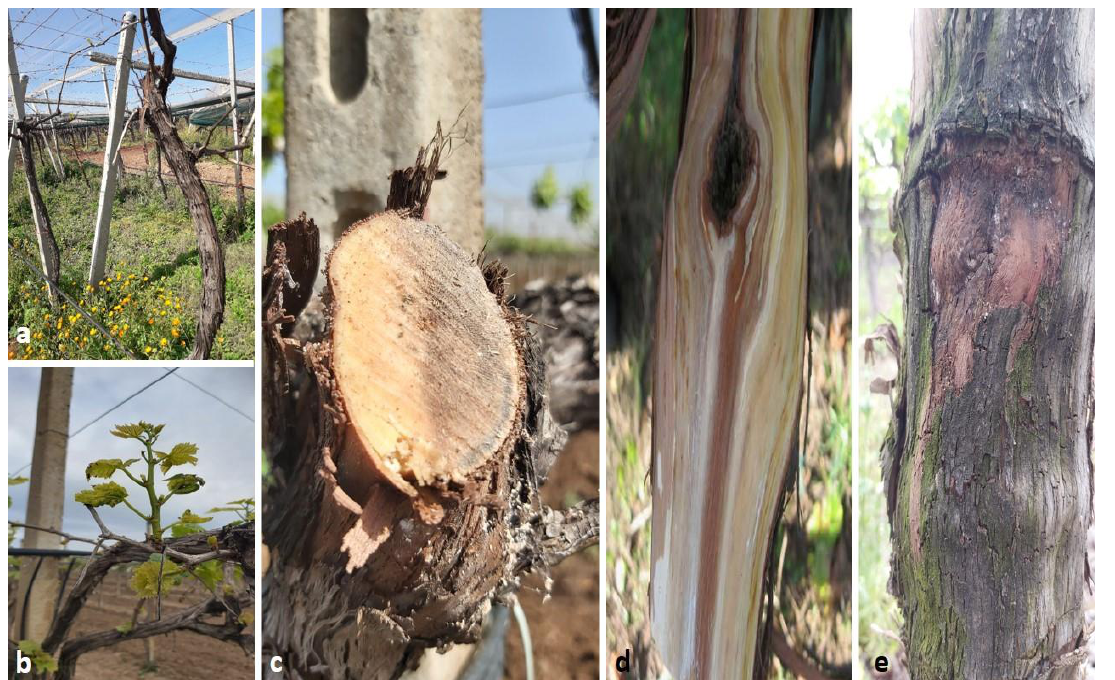
Figure 1. Infected grapevines displaying several symptoms in different Doukkala vineyards. ( a ) Typical dieback of grapevines; ( b ) grapevine showing overall stunting with short shoot internodes; ( c ) characteristic necrosis of Botryosphaeria dieback; ( d ) bark peeling with a brown strip and ( e ) symptoms of canker, reddish-brown with well-demarcated elliptical areas on the outer surface of the vine trunk.